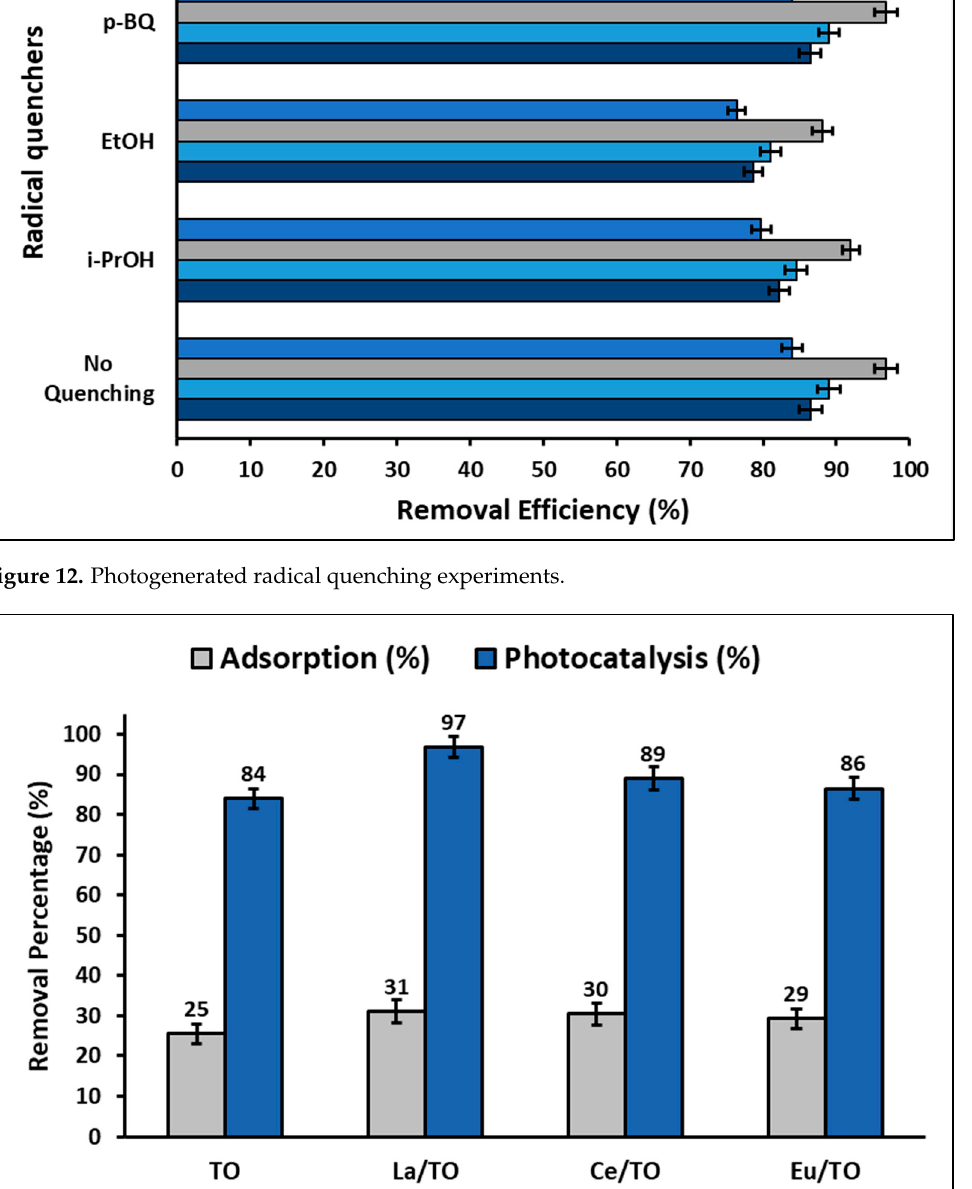
Figure 14. Nanoparticle reuse experiment. 4. Discussion 4.1. Characterization of Nanoparticles 4.1.1. XRD and SSA Analysis The results depicted in Figure 1 indicate that doping with lanthanide (Ln) can impact the crystal structure of pure TiO 2 (anatase), causing slight broadening and reduction in intensity of its characteristic diffraction peaks. This suggests that the adsorbent and photocatalytic properties of this semiconductor oxide can be affected by the presence of Ln dopants [76]. According to the literature, it is very difficult for lanthanide ions to substitute Ti 4+ ions in the TiO 2 crystal lattice. This is primarily due to the significant difference in ionic radii between Ti 4+ (0.068 nm) and the lanthanide ions, such as La 3+ (0.116 nm), Ce 3+ (0.114 nm), Ce 4+ (0.101 nm), and Eu 3+ (0.107 nm). Therefore, La 3+ , Ce 3+/4+ , and Eu 3+